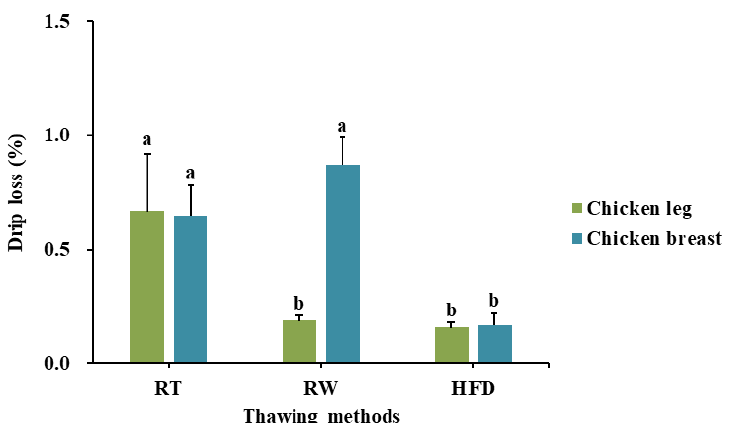
Figure 2. Comparison of drip loss percentage in defrosted samples using different thawing methods (RT, room temperature; RW, running tap water; HFD, high-frequency defroster). Values are mean ± SE. Different letters (a,b) in each column indicate significant differences among the means by Tukey’s test ( p < 0.10).